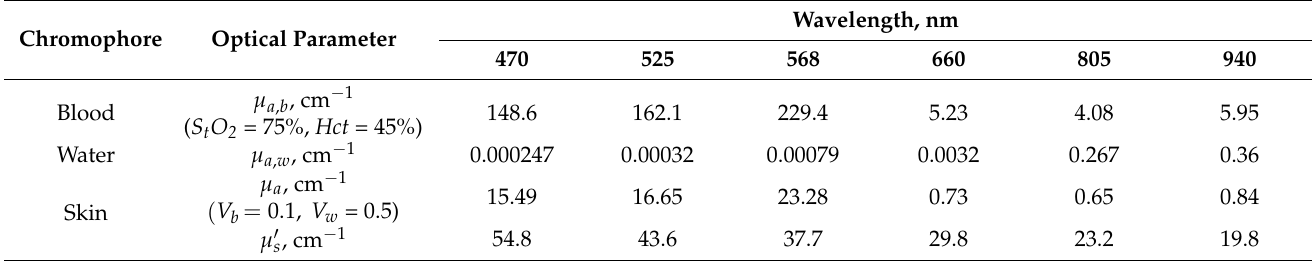
Dependences of Z ( d , λ ) on d computed by Equation (2) for all six wavelengths are